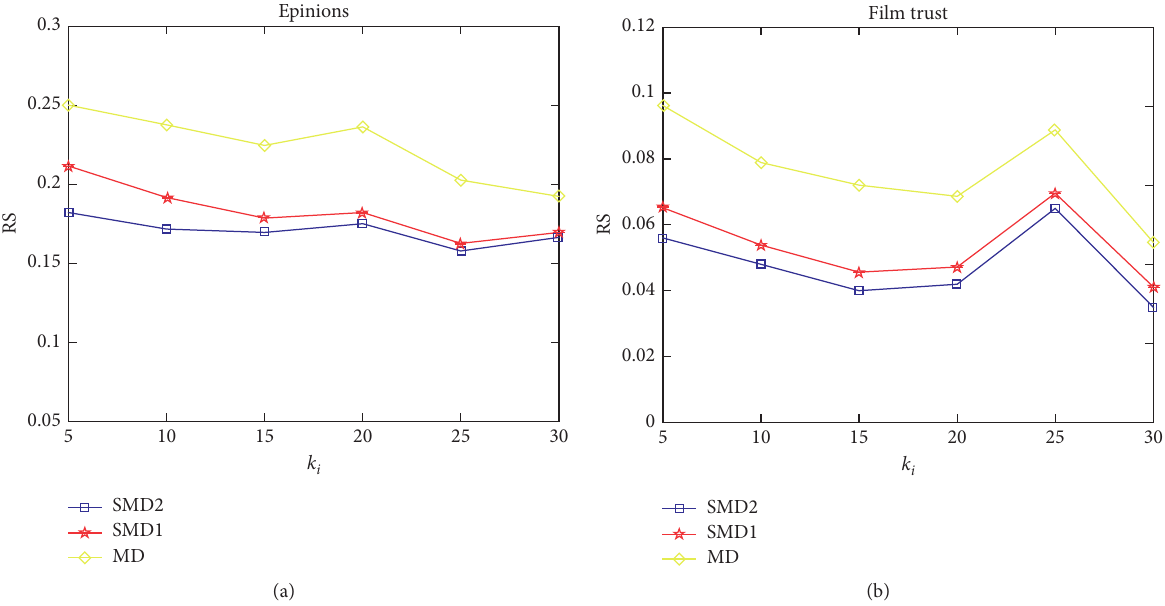
Figure 10: The comparison of optimal RS values under SMD and MD for small-degree users. (a) Epinions dataset. (b) FilmTrust